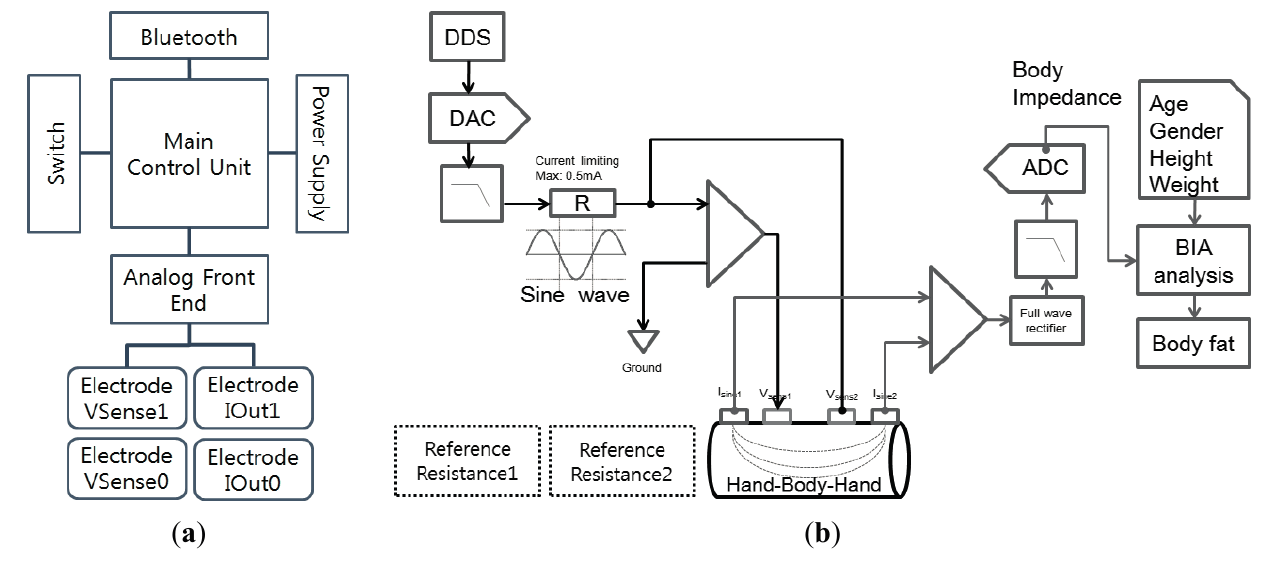
Figure 1. Hardware block diagram of ( a ) overall system and ( b ) the analog front end.